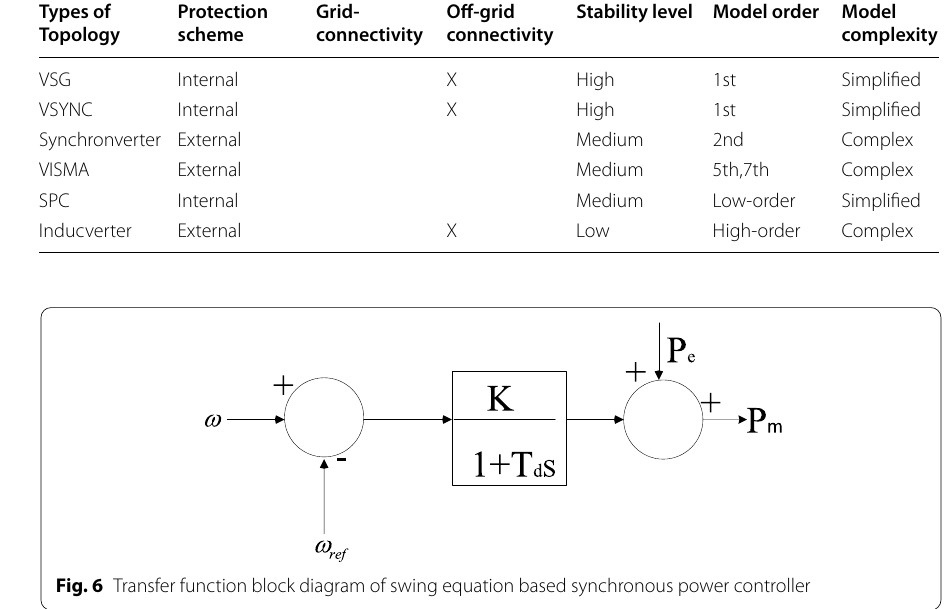
Table 7 Comparative analysis of virtual inertia control parameters Types of Topology